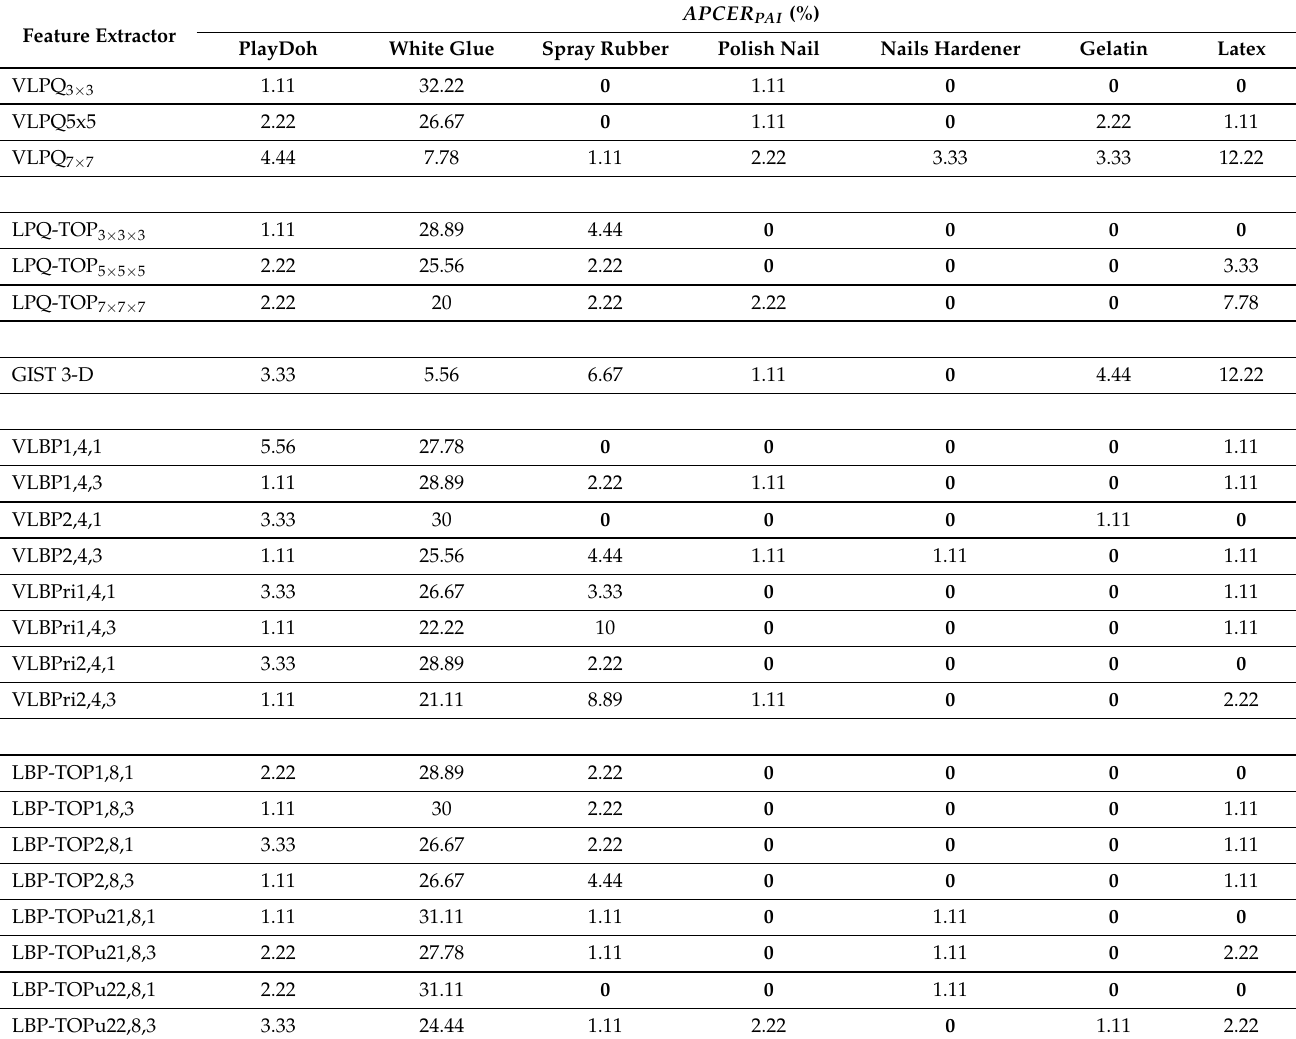
Table 9. PAD subsystem performance for the thermal